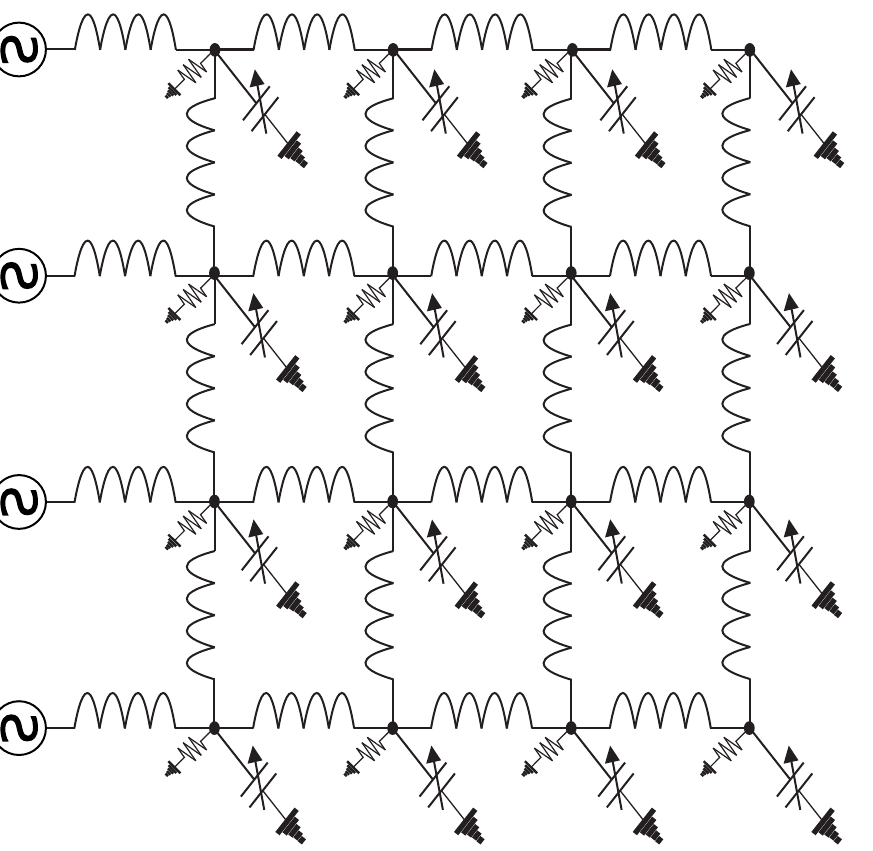
Figure 3. An example of a nonlinear lattice. A nonlinear lattice is a nonlinear electrical network on a two-dimensional rectangular grid graph.